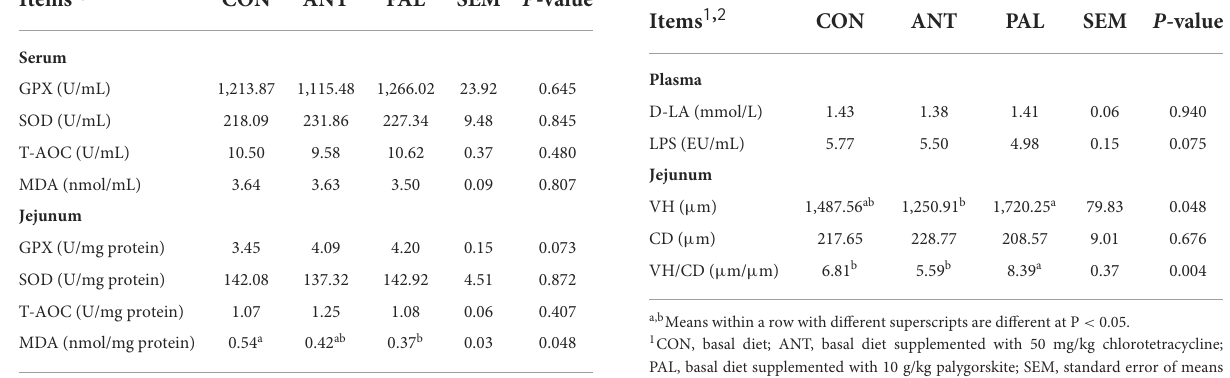
TABLE 3 Effects of dietary palygorskite supplementation on the antioxidant status in broilers.